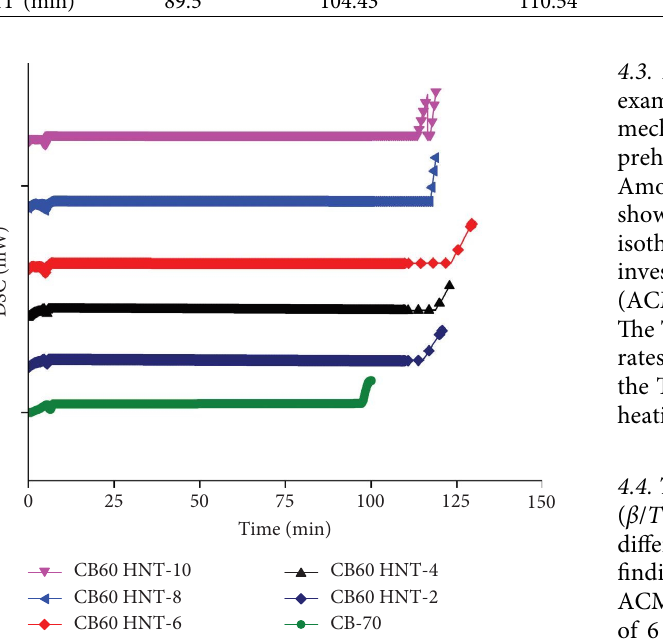
Figure 1: OIT values of ACM